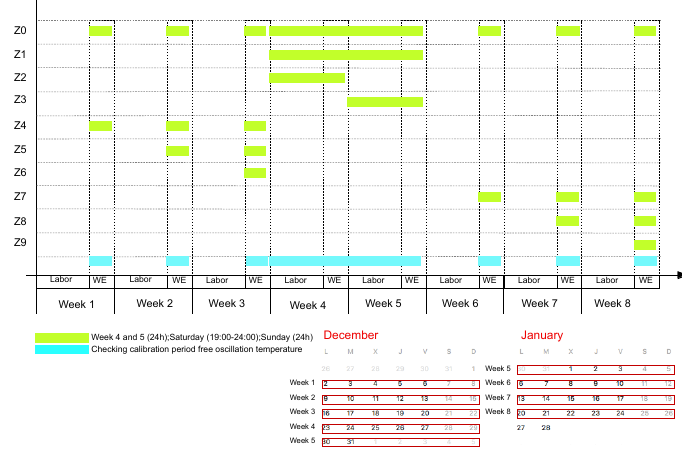
Figure 4. Different calibration